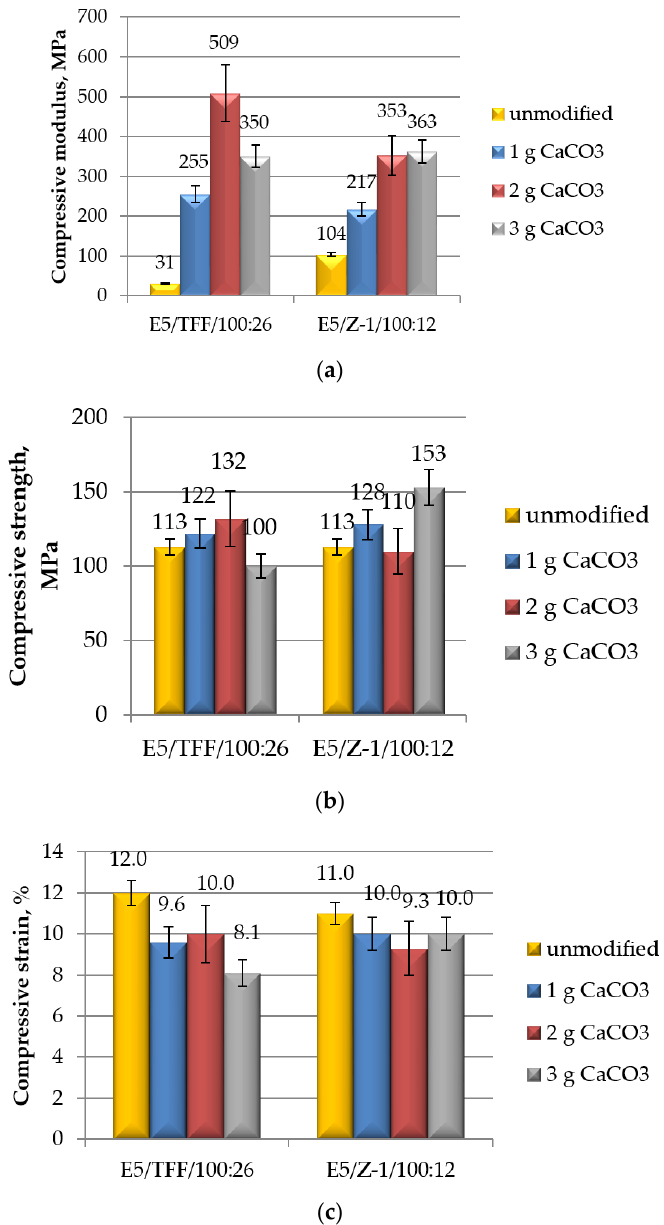
Figure 3. Results of mechanical (in compression mode) tests performed on un-aged control specimens, i.e., E5/TFF/100:26 and E5/Z-1/100:12, and on un-aged epoxy compounds filled with different amounts of CaCO 3 : ( a ) compressive modulus; ( b ) compressive maximum strength; and ( c ) compressive strain at break.